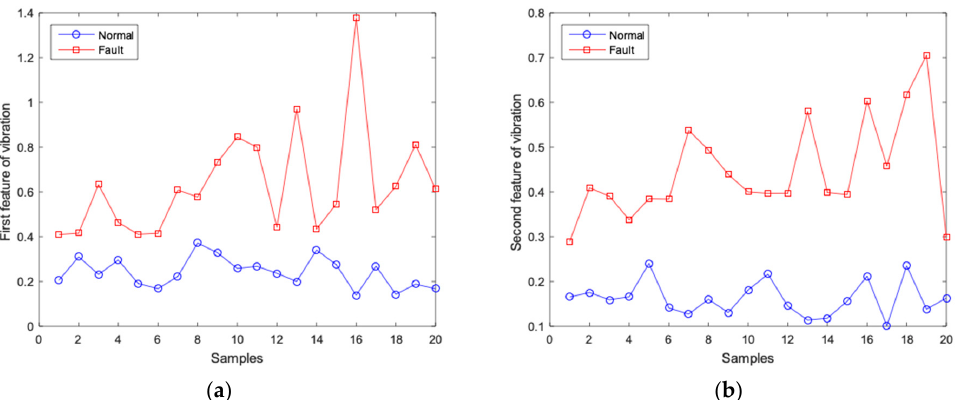
Figure 11. Features extracted from the vibration signals ( a ) First feature of vibration; ( b ) Second feature of vibration.